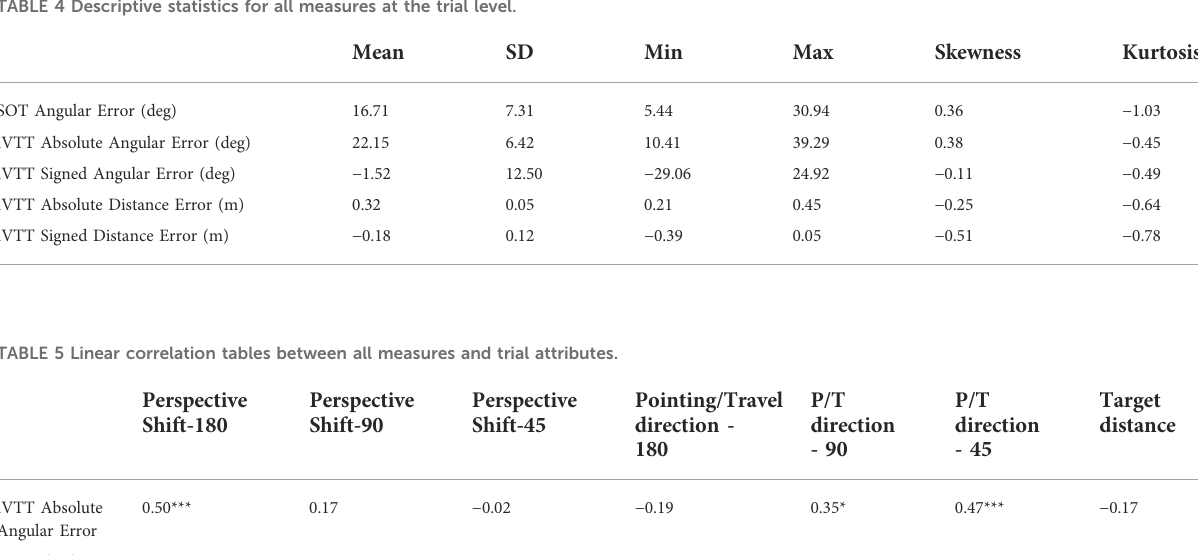
TABLE 4 Descriptive statistics for all measures at the trial level.